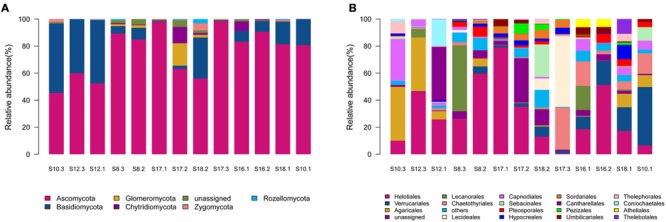
The relative abundances of different phyla (A) and orders (B) in the thirteen soil samples in the present study. The 13 soil samples were arranged in the order of the pH values (from the lowest pH in the left to the highest pH in the right).